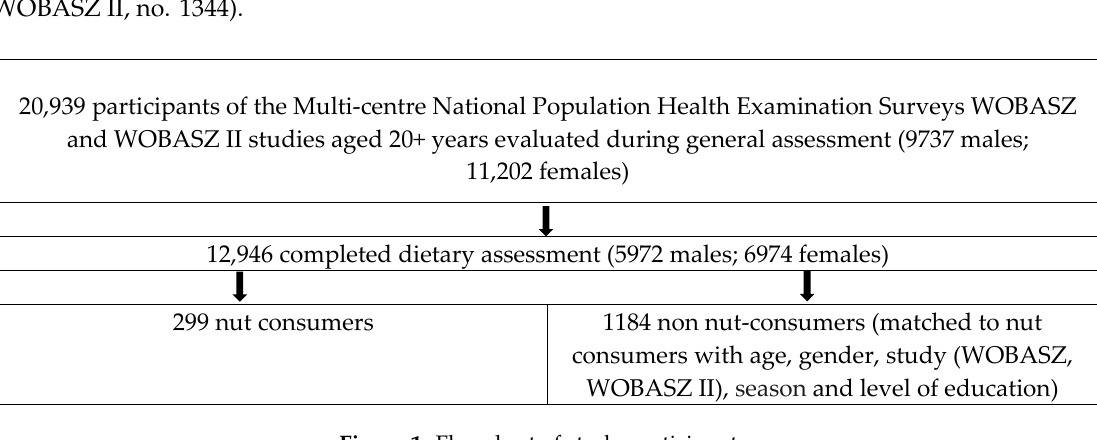
Figure 1. Flowchart of study participants. 2